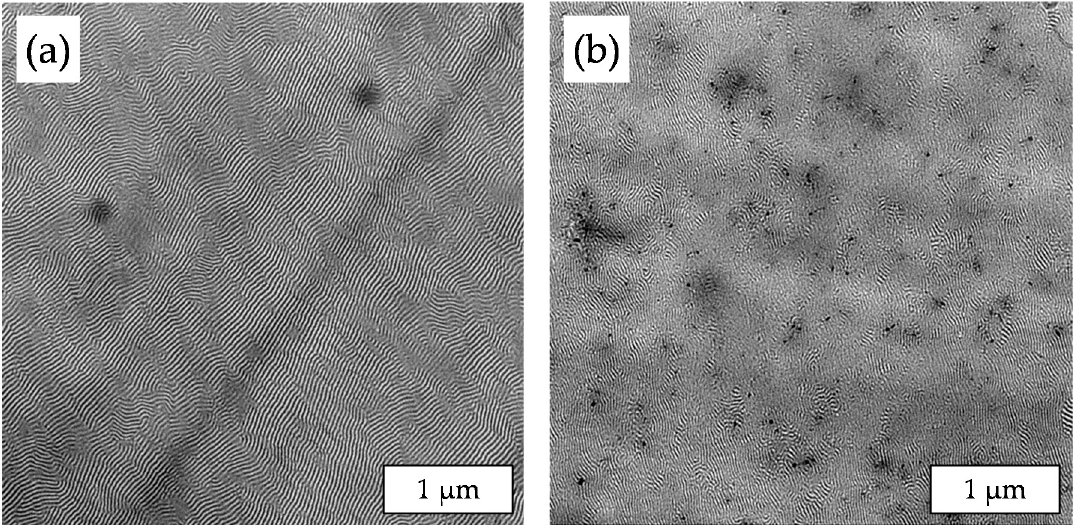
Figure 4. Morphology images from TEM of ( a ) LN3_C and ( b ) LN3_1_C .